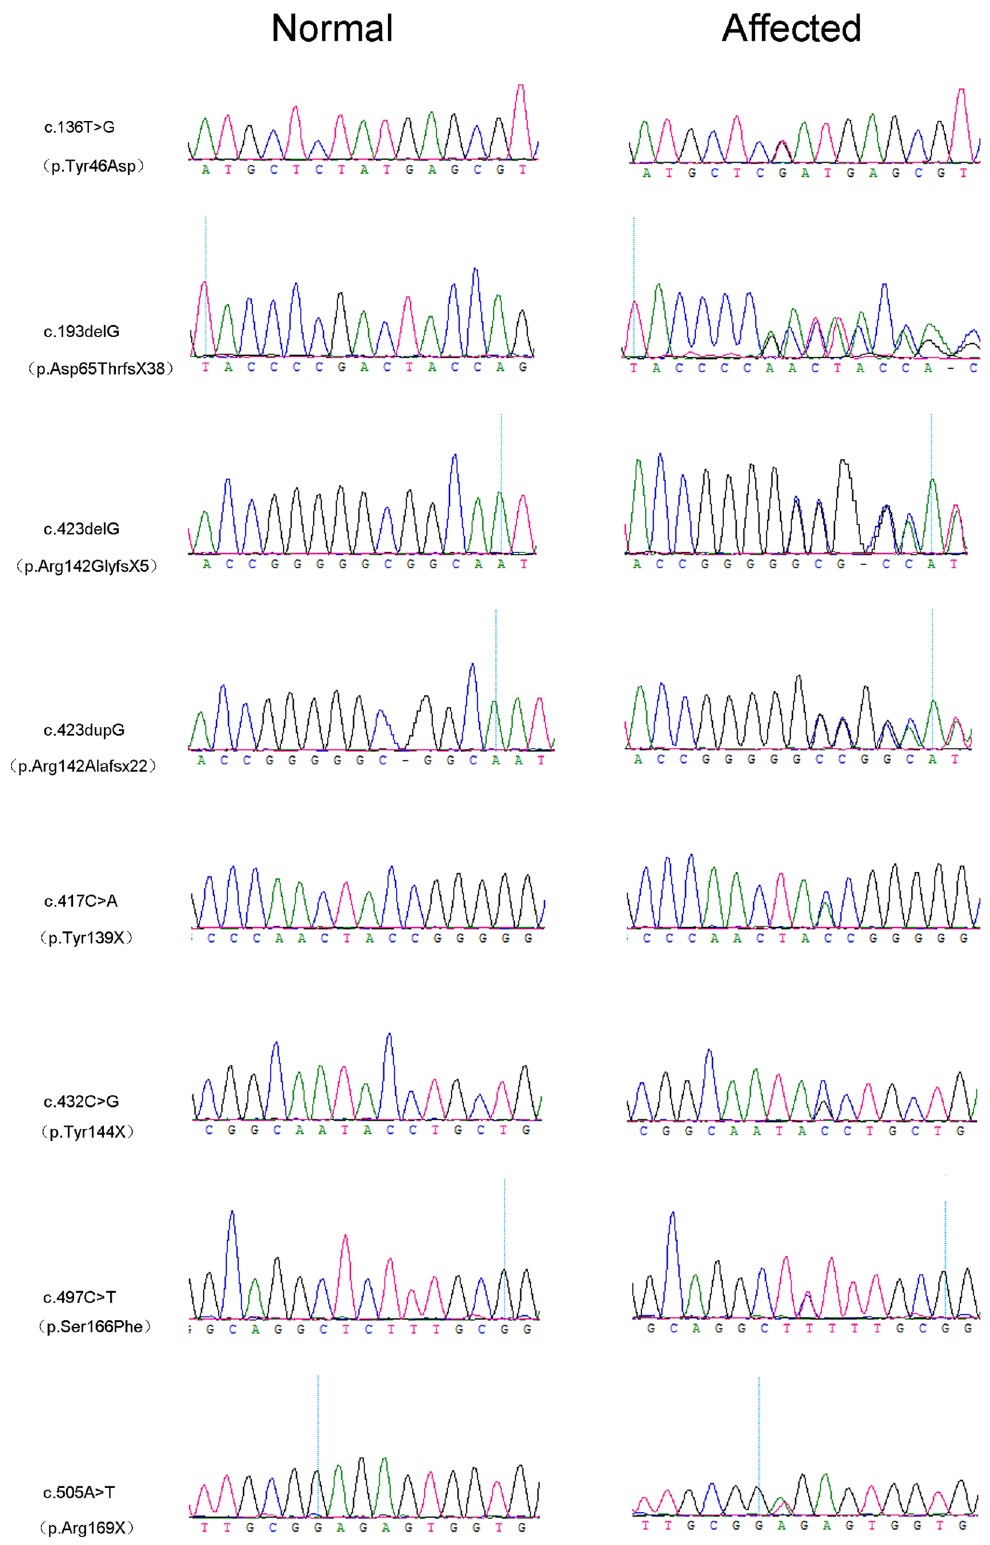
Figure 2. DNA sequences of GRYGC in affected and control individuals. Sequence chromatograms show eight identified heterozygous mutations and their wild type